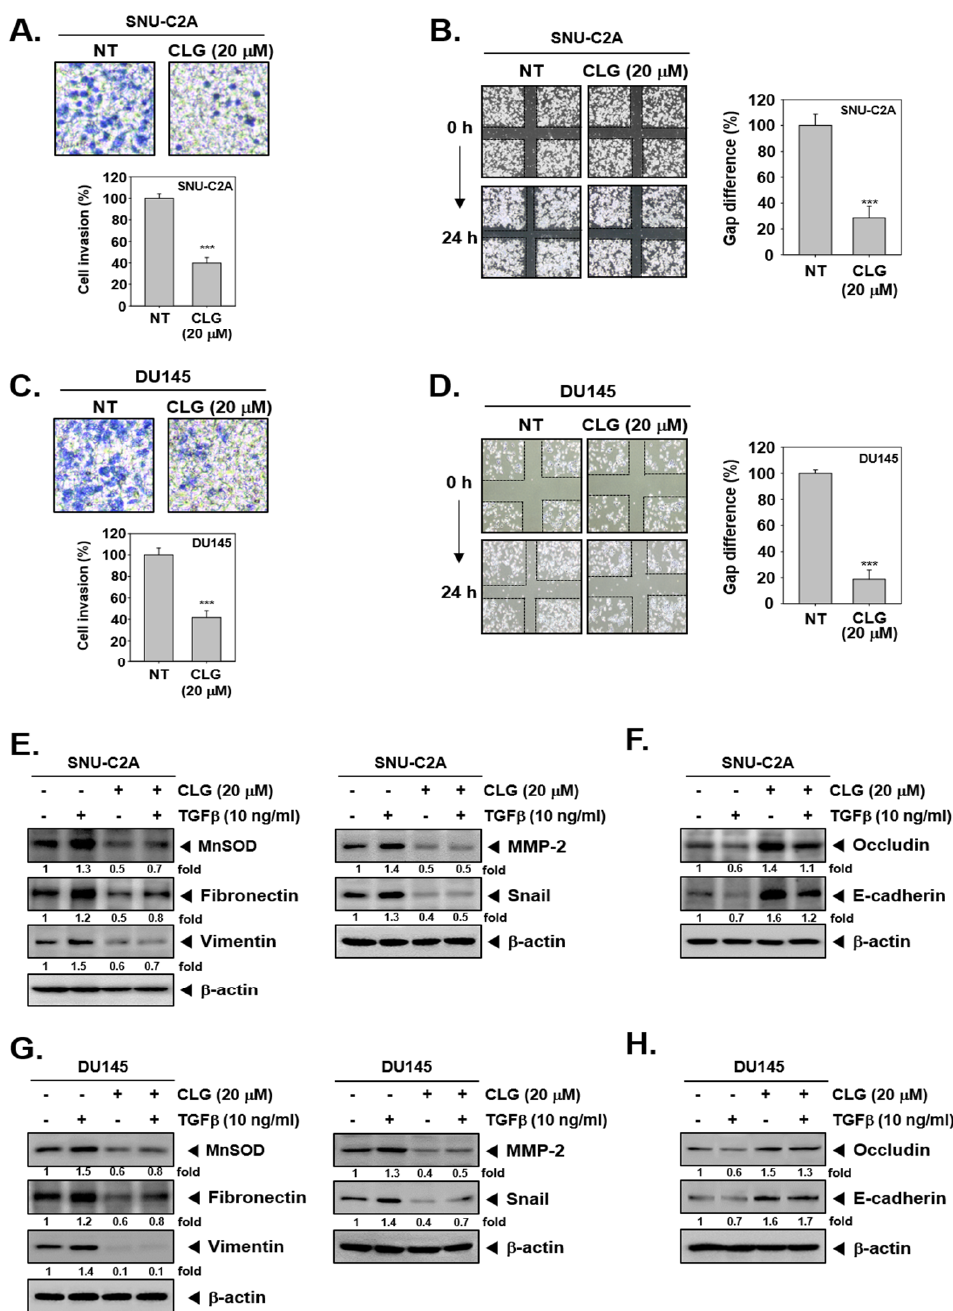
Figure 2. CLG suppressed invasion as well as migration. SNU-C2A and DU145 cells were exposed to CLG (20 µ M) for 24 h. ( A and C ) Invasive activity was measured by Boyden chamber assay in SNU-C2A and DU45 cells. Data represent means ± SD. *** p < 0.001. ( B and D ) The cells were scratched and wound healing assay for evaluate cell migration. Data represent means ± SD. *** p < 0.001. ( E – H ) SNU-C2A and DU145 cells were treated with TGF β (10 ng / mL), CLG (20 µ M), or a combination for 24 h. Whole cell lysates were extracted and expression of EMT-related proteins was analyzed by western blotting. The results shown are representative of the three independent experiments.